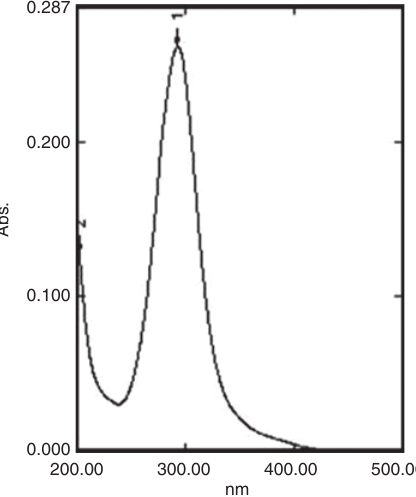
Figure 5: Ultraviolet-visible (UV-Vis) spectrum of 11,15-dimethyl- hexadeca-8,10,14-trien-7-one isomers. isomers. In Table 4, it can be observed that the predicted UV-Vis wavelength number (293) is similar to the experi-